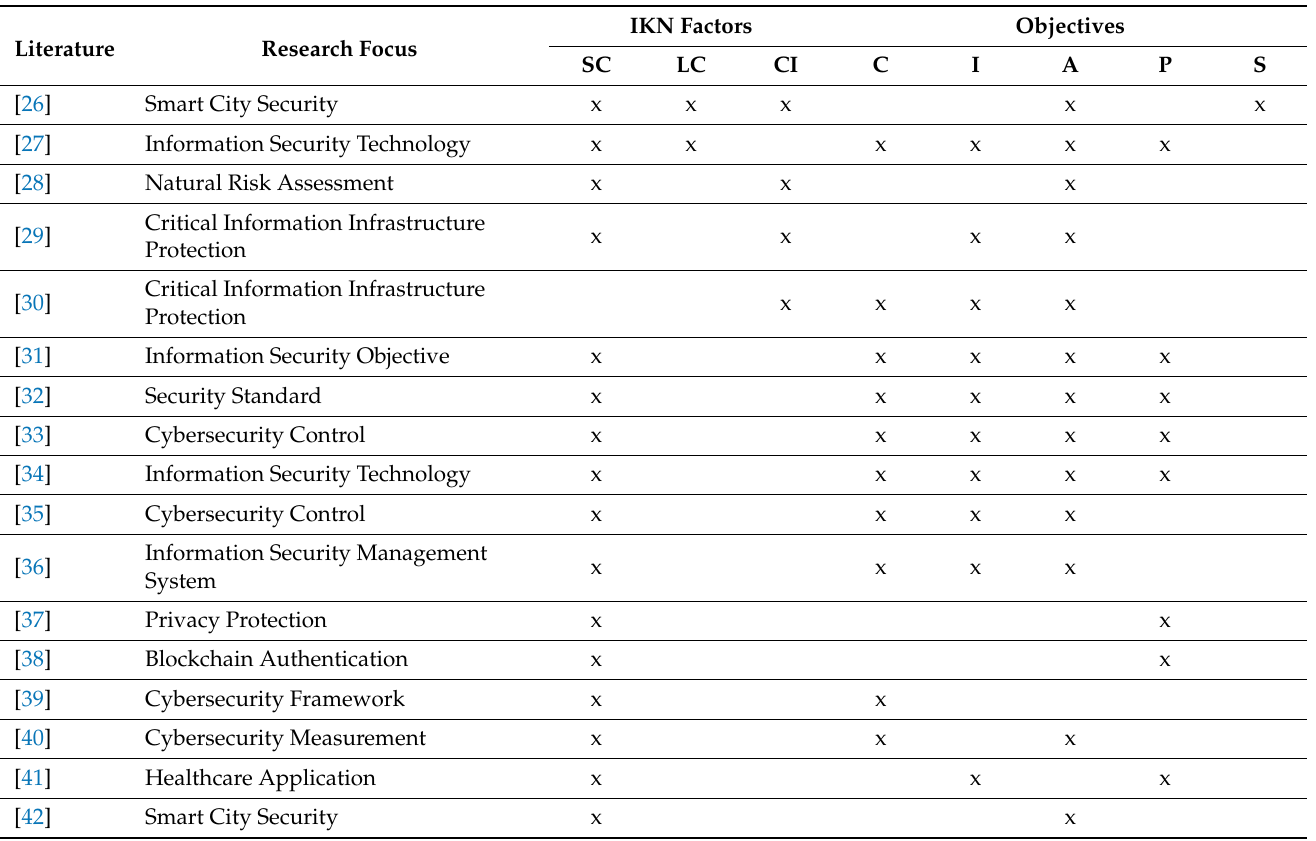
Table 2. IKN factors and security